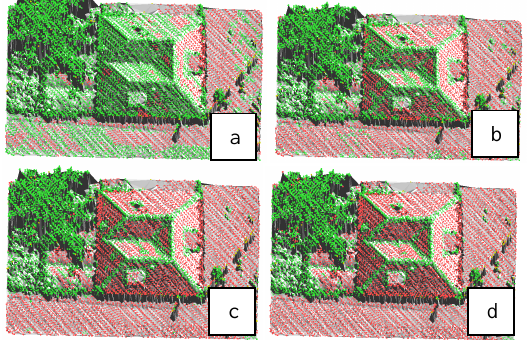
Figure 4. Detected planar points using threshold of 0.005 (a), 0.01 (b), 0.015 (c) and 0.02 (d) for local surface variation index. Red indicates planar points while green for non-planar points.